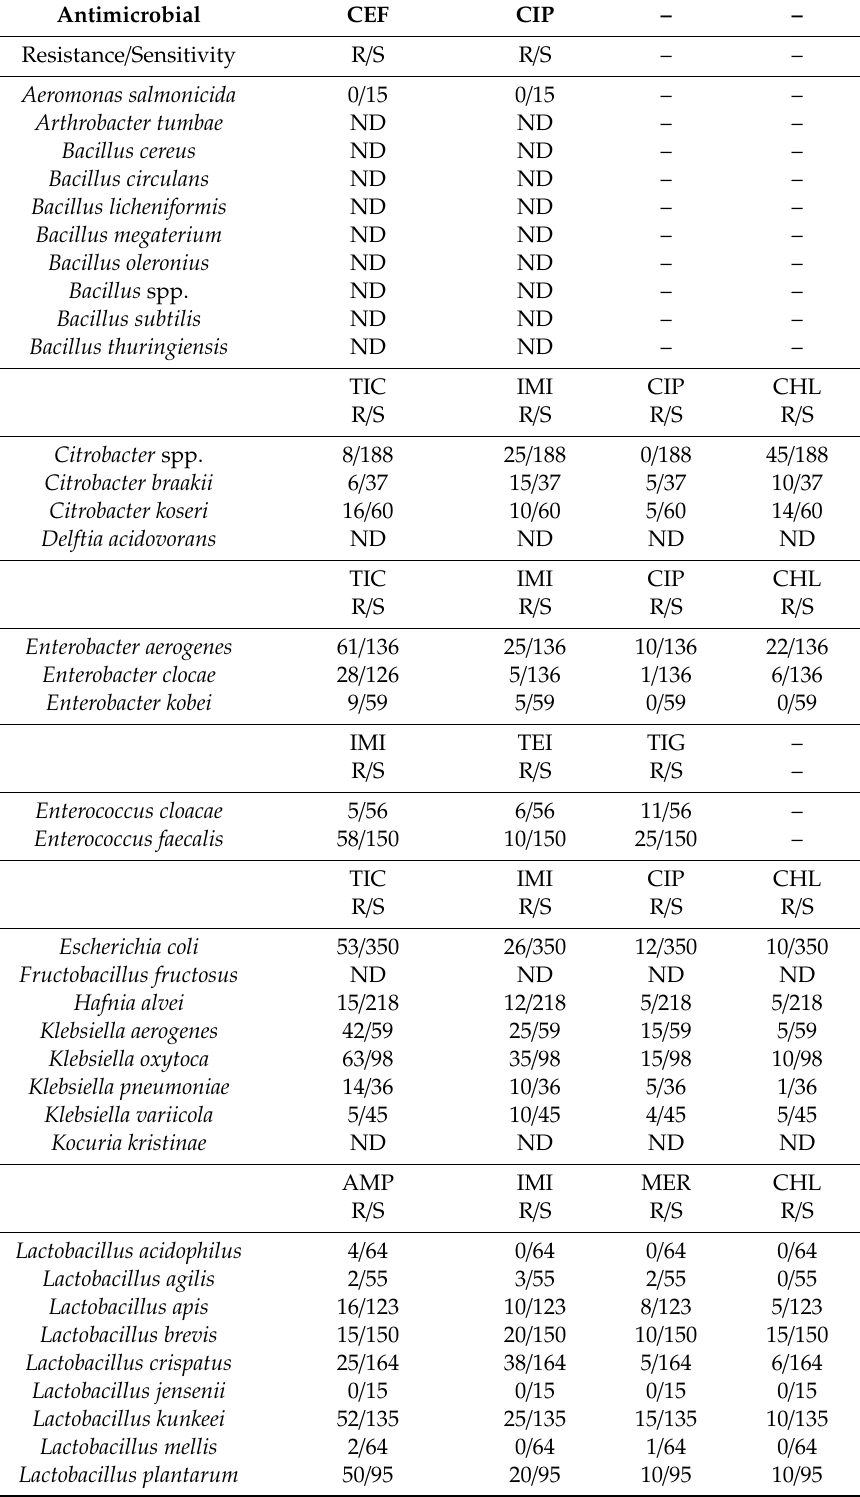
Table 4. Antimicrobial resistance of bacteria isolated from bee digestive